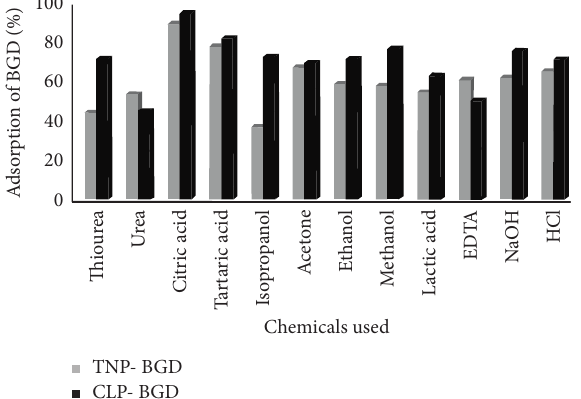
Figure 3: Comparative adsorption behavior of TNP and CLP after modification with different